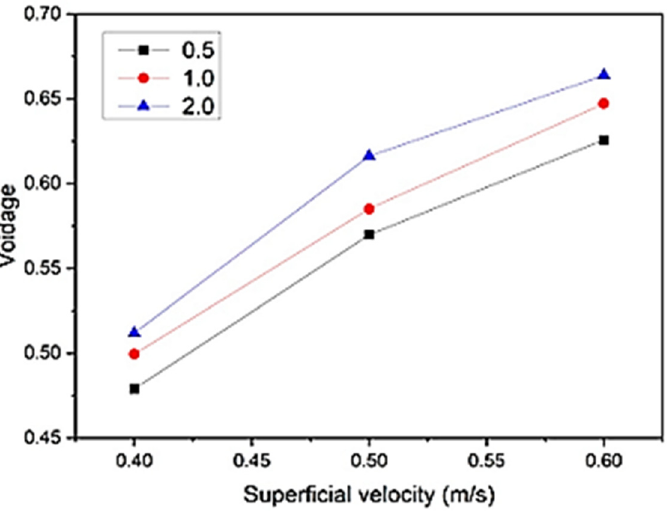
Figure 16. Temporally and spatially averaged bed voidage as a function of superficial velocity and aspect ratio [147].